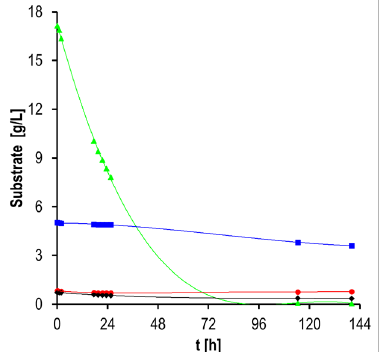
Figure 2. Substrate consumption by C. maltosa SM4 on RBY for 200 rpm, 1 L air min − 1 : Ethanol ( (cid:78) ), Glucose ( (cid:4) ), Xylose ( • ) and arabinose ( (cid:7)